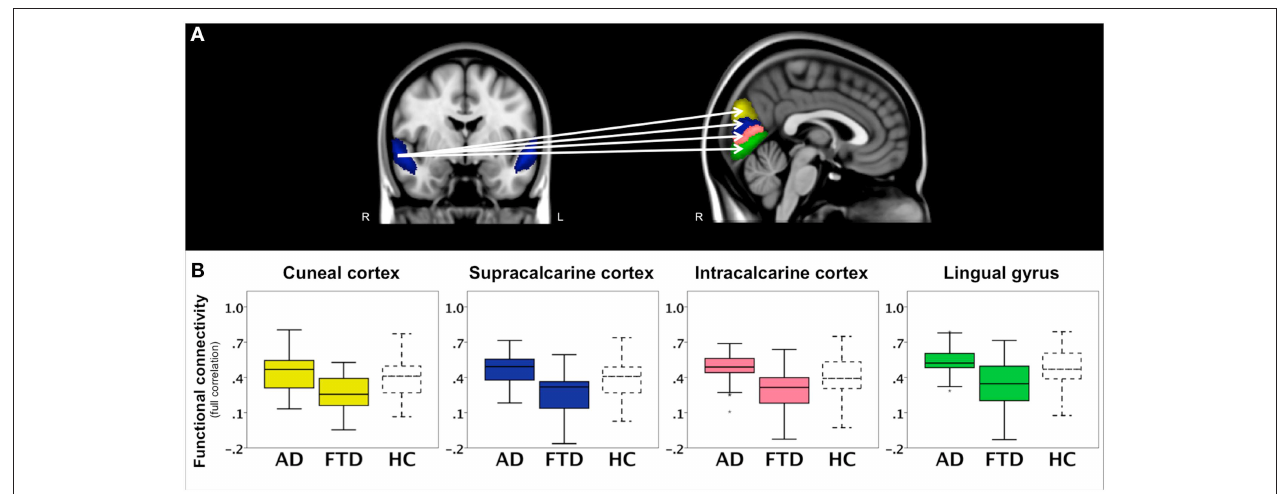
FIGURE 3 | Functional connectivity in bvFTD vs. AD: region-to-region connectivity. Differences in pairwise functional connectivity between behavioral variant frontotemporal dementia (FTD) and Alzheimer’s disease (AD). (A) Decreased functional connectivity between right superior temporal gyrus (blue area, coronal slice) and cuneal cortex (yellow), supracalcarine cortex (blue), intracalcarine cortex (pink), and lingual gyrus (green) in bvFTD compared with AD. Images show brain areas based on the probabilistic Harvard-Oxford structural atlas overlaid on coronal and sagittal slices of the MNI-152 standard anatomical image. (B) Subjects’ correlation scores were extracted from brain areas with differences in functional connectivity between the two patient groups (right cuneal, supracalcarine, intracalcarine cortex, and lingual gyrus). Boxplots show median, lower, and upper quartile, and sample minimum and maximum correlation scores for patients with AD, patients with bvFTD, and healthy controls (HC, dotted